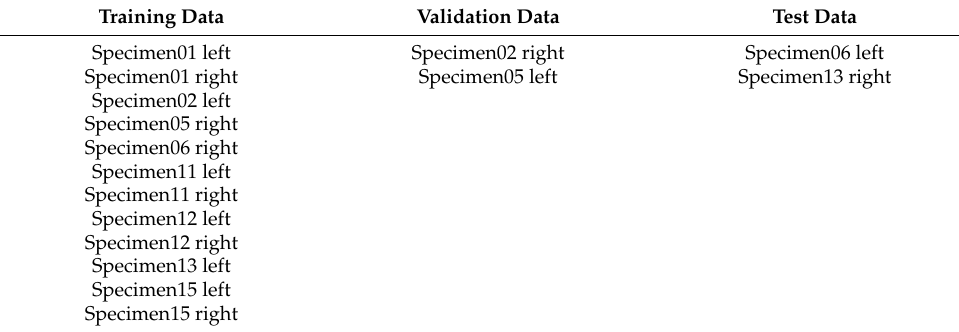
Table 4. Data splitting for LWIR and